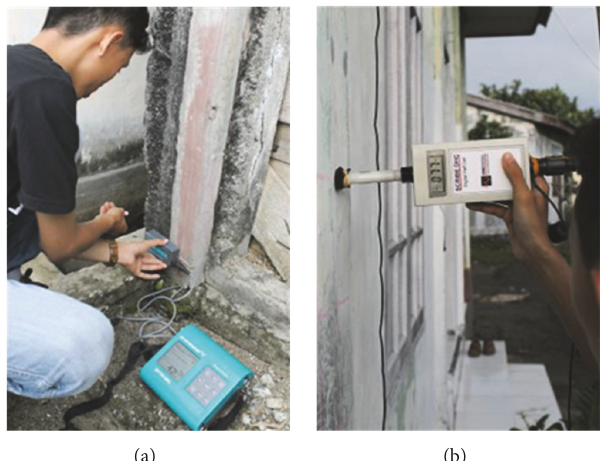
Figure 9: (a) Measurement of the location of steel reinforcement and (b) potential corrosion measurement of the column.